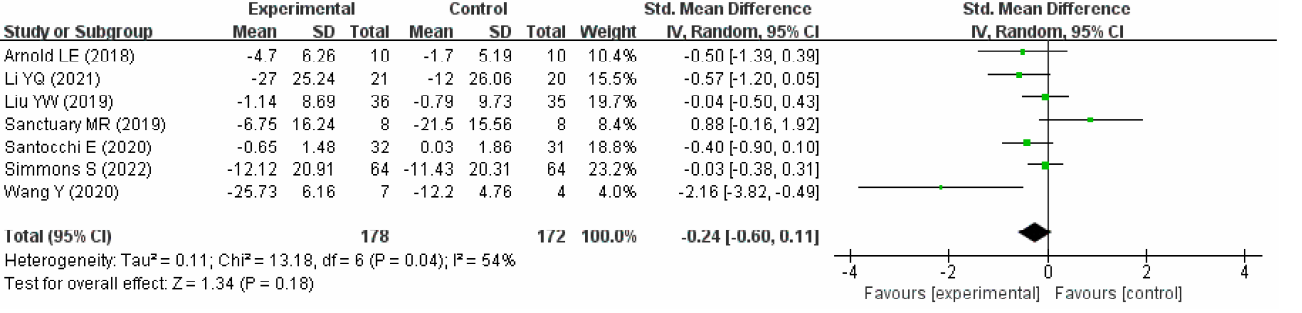
Figure 4. Forest plot for the effect of probiotics on improvement in autism-related behavioral symptoms [23,25–30].